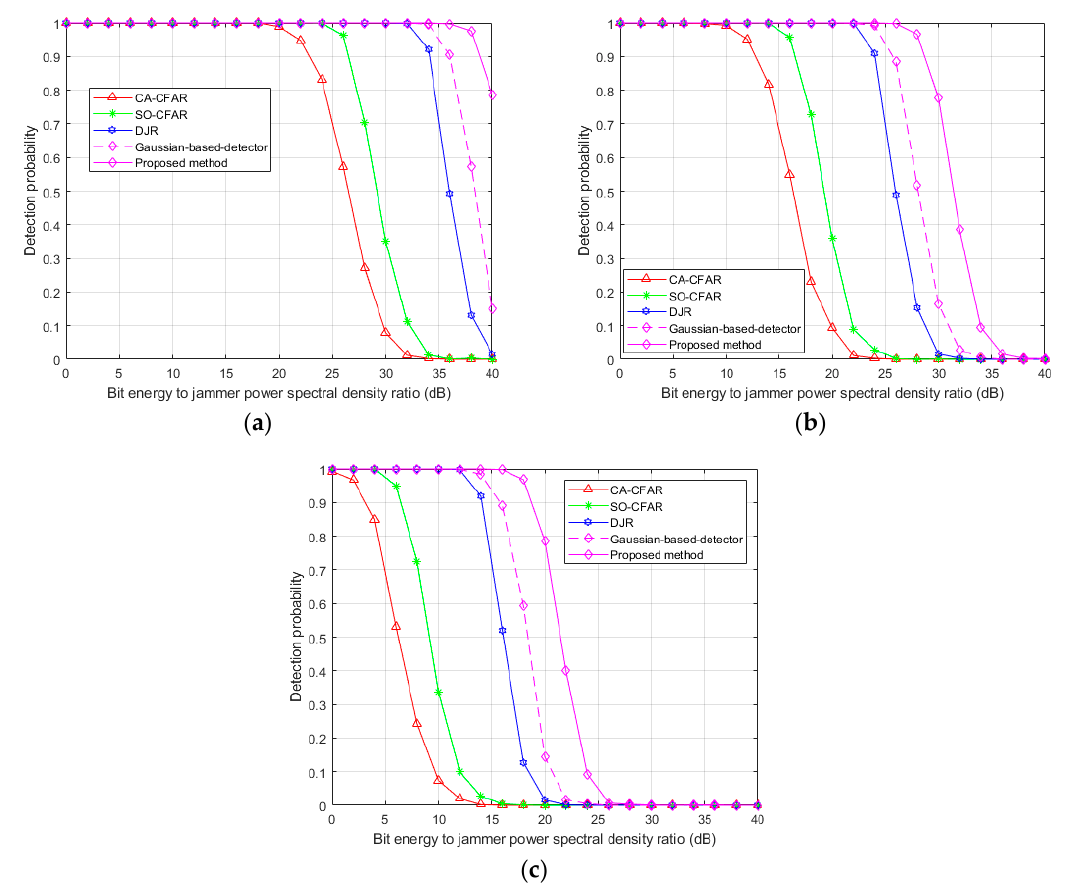
Figure 4. Detection probability: ( a ) ρ = 0.0005, ( b ) ρ = 0.005, ( c ) ρ = 0.05.